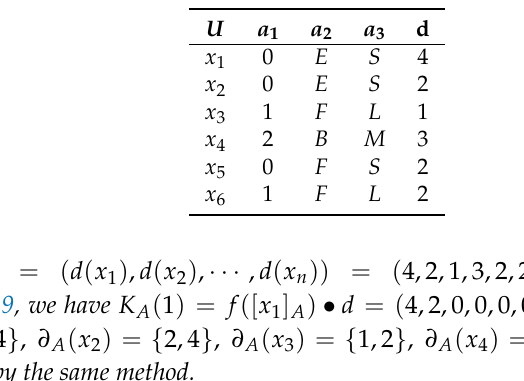
Table 4. An inconsistent decision